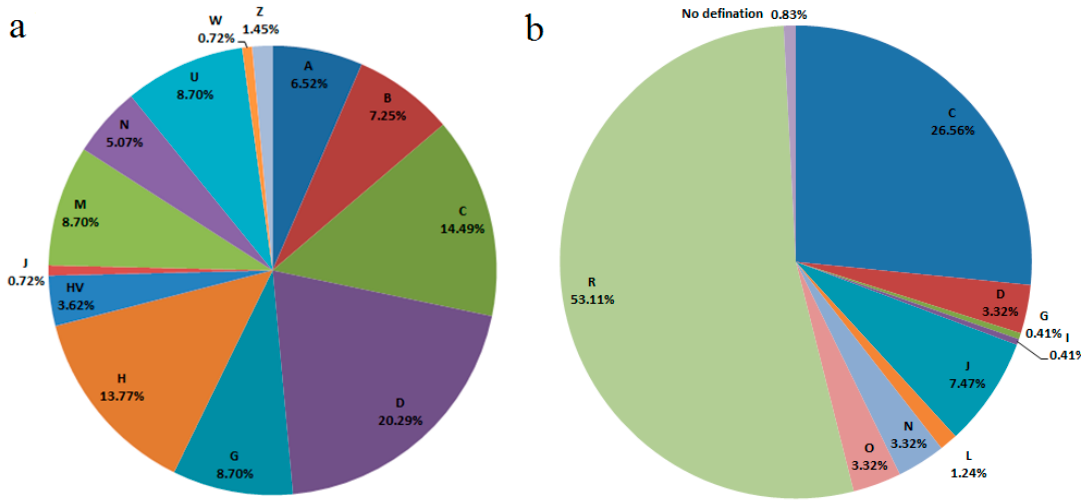
Figure 1. The pie charts for the haplogroup frequencies of the Kyrgyz group, ( a ) based on 59 mtDNA loci in 138 individuals, haplogroup M in this plot excluded haplogroups C, D, G and Z; haplogroup N in this plot excluded haplogroups A, B, J, H, HV, U and W; ( b ) based on 23 Y-STRs in 241 male individuals.